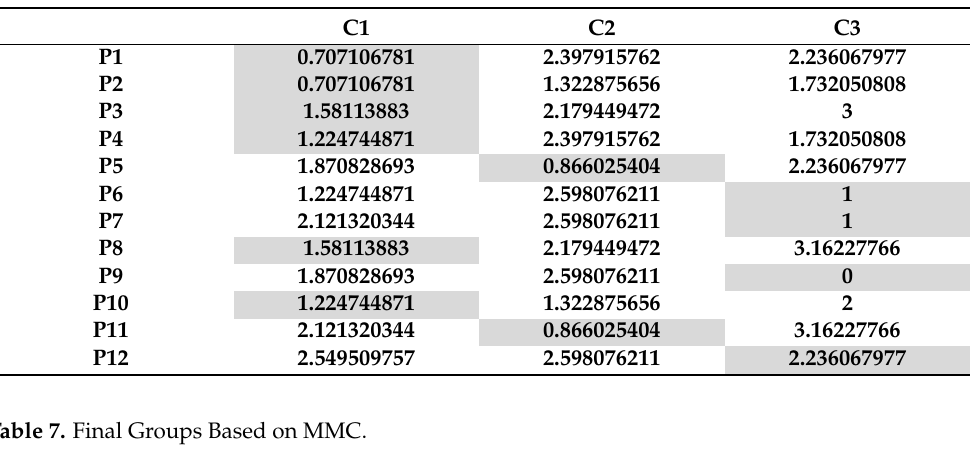
Table 6. Similarity of Temporary Groups for Older People.